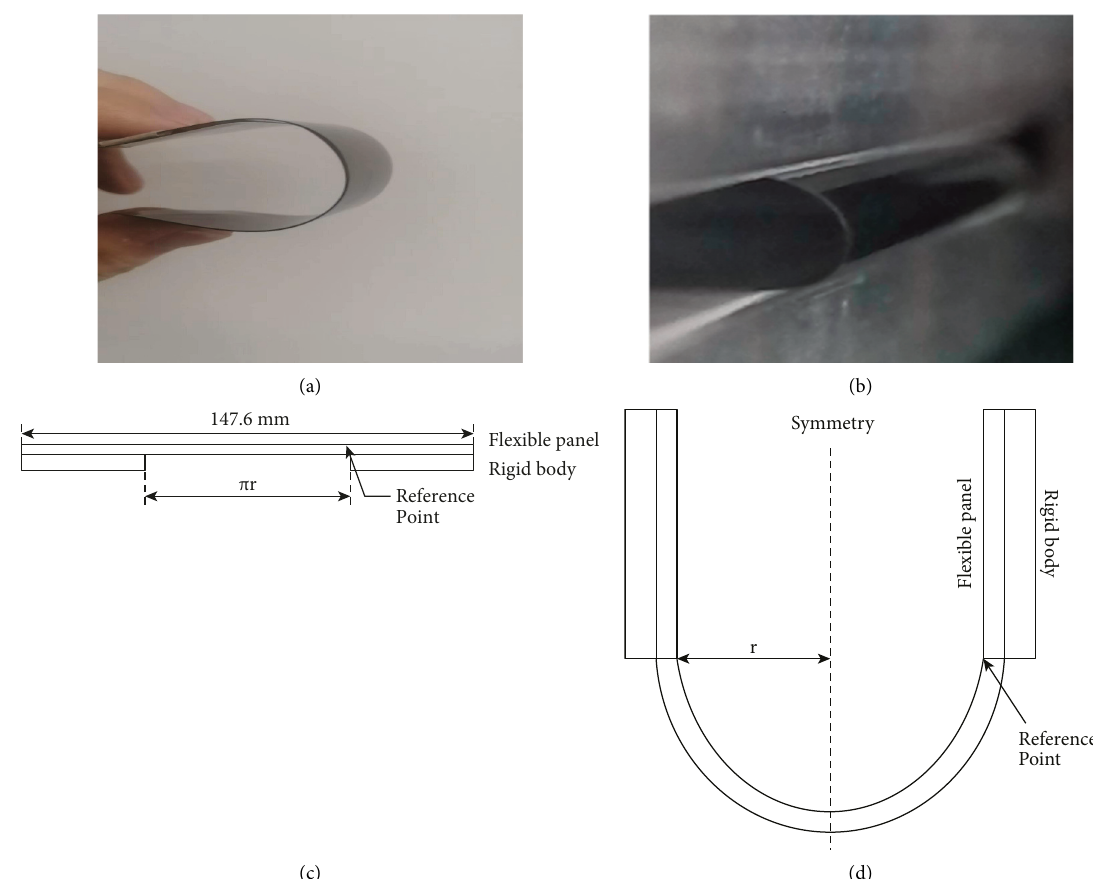
Figure 1: (a) Schematic diagram of U-shaped bending of the flexible screen. (b) Flexible screen U-shaped experimental bending diagram. (c) Schematic representation of the model before folding. (d) Schematic diagram of the model after folding.